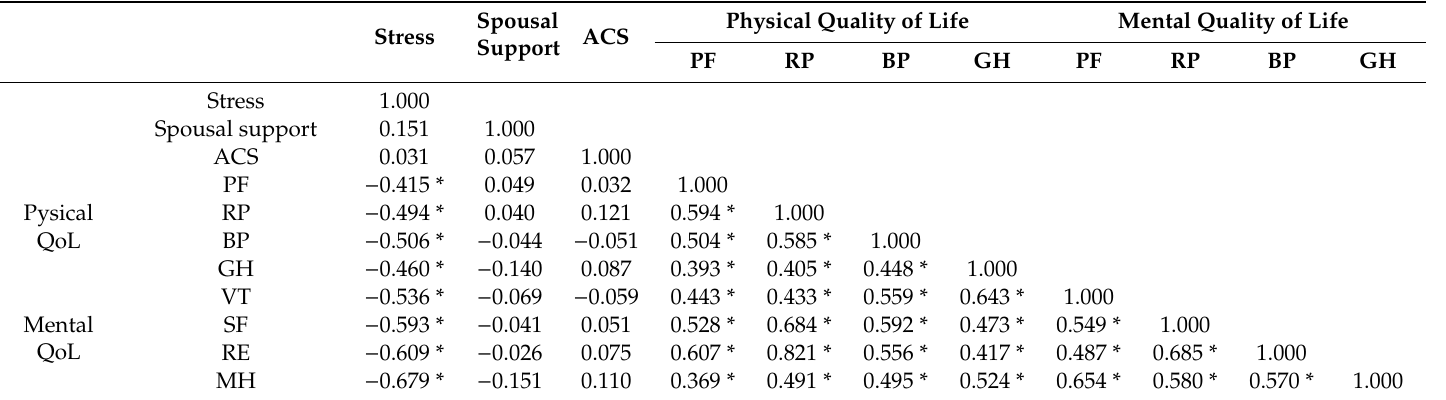
Table 3. Pearson’s correlation analysis of stress level, spousal support, ACS guideline adherence, and health-related quality of life.